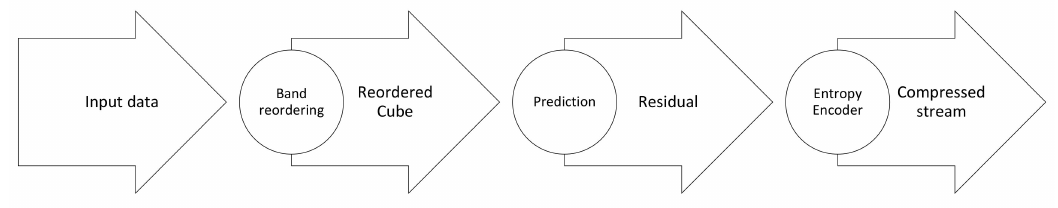
Figure 10. Main steps involved in prediction-based compression of